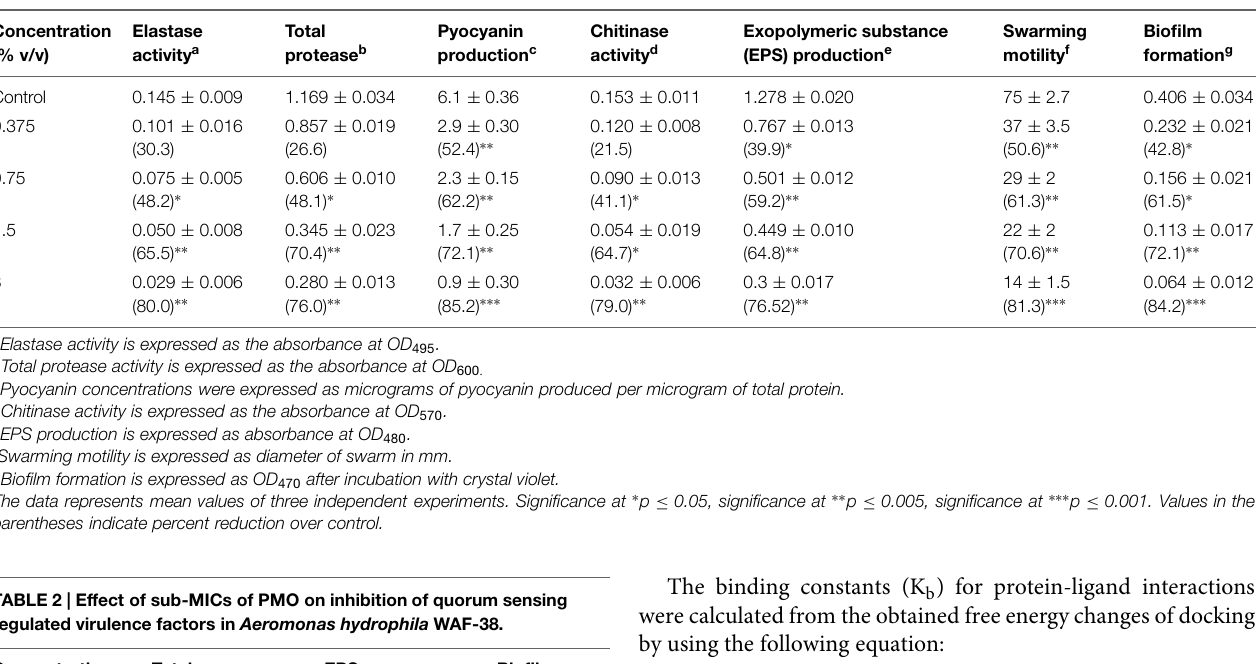
TABLE 1 | Effect of sub-MICs of peppermint oil (PMO) on inhibition of quorum sensing regulated virulence factors in Pseudomonas aeruginosa PAO1.